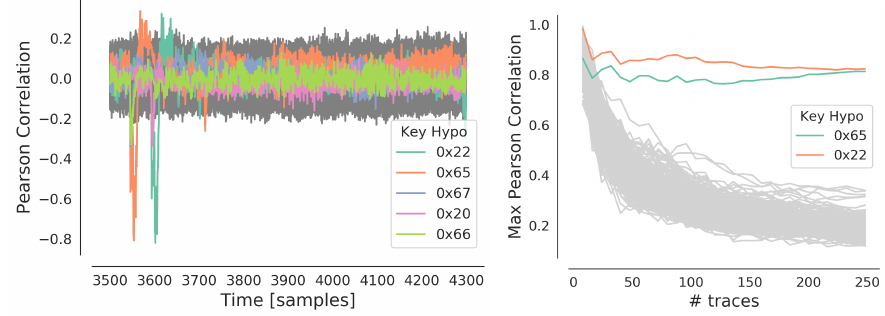
Figure 20: Pearson Correlation coefficients in Step 2 (bytes 0 and 1), with 256 traces as a function of the time samples (left) and their maximum as a function of the number of traces (right).